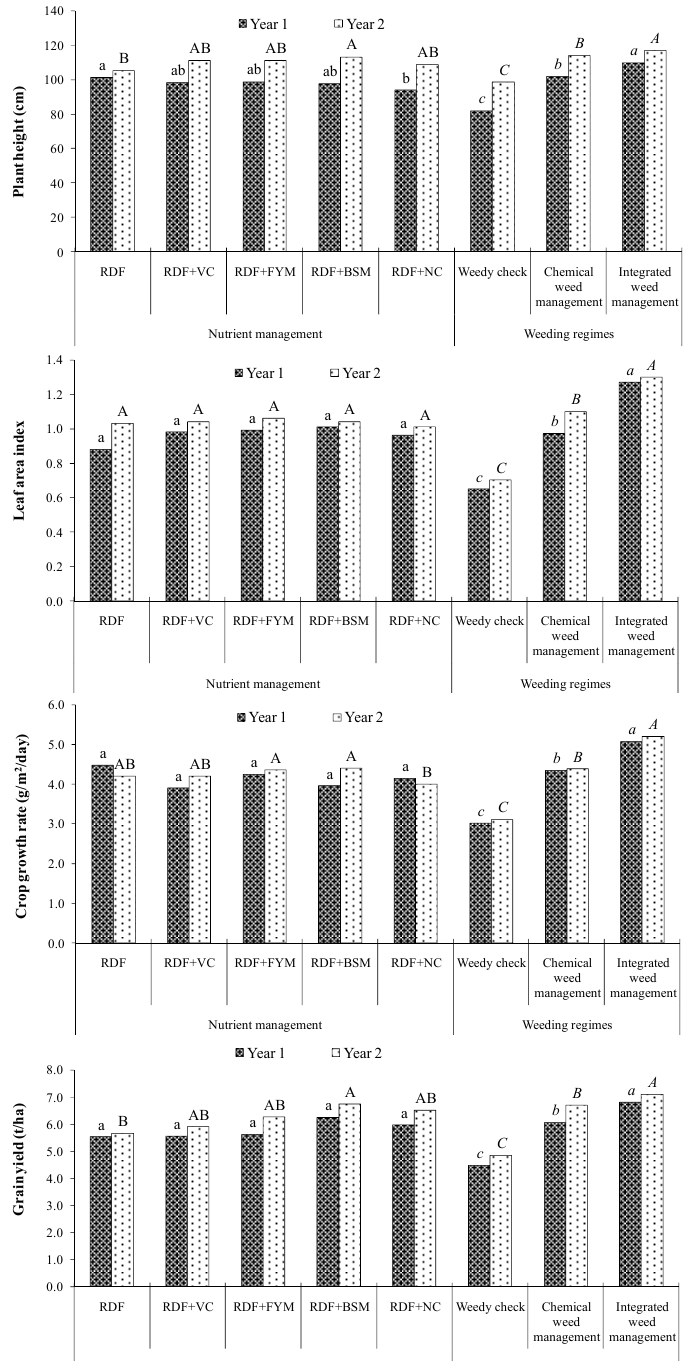
Figure 3. Effect of different nutrient managements and weeding regimes on plant height, leaf area index (LAI) recorded at 60 DAS, crop growth rate (CGR) recorded at 60–90 DAS, and grain yield of hybrid maize. RDF: 100% recommended dose (RD) of NPK through fertilizer, RDF + VC: 25% RDN through VC, RDF + FYM: 25% RDN through FYM, RDF + BSM: 25% RDN through BSM, RDF + NC: 25% RDN through NC, Weedy check: Un-weeded control, Chemical weed management: Atrazine 1000 g/ha at 2 DAS, Integrated weed management: Atrazine 1000 g ha -1 at 2 DAS followed by mechanical weeding at 30 DAS. Effects of nutrient source in year 1 as lower case (a, b or ab), in year 2, upper case (A, B or AB), whereas effect of weed management in year 1 as italic lower case ( a, b or c ), in year 2 ( A, B or C ), italic upper case.